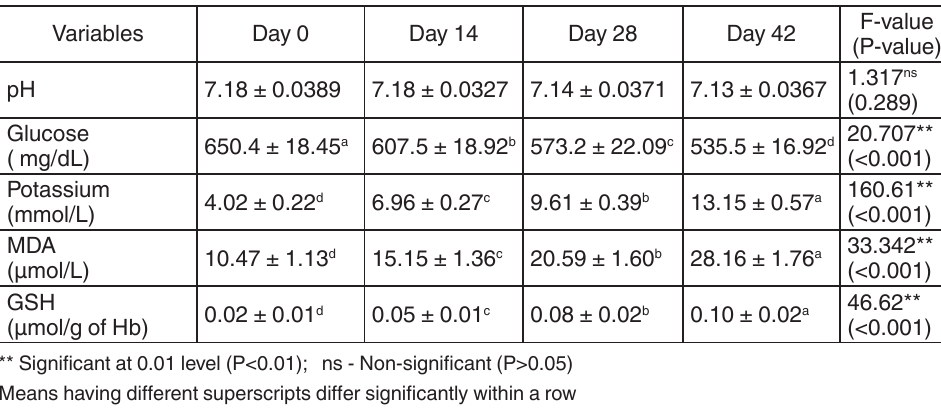
Table 1. Variation of bio-chemical parameters during storage